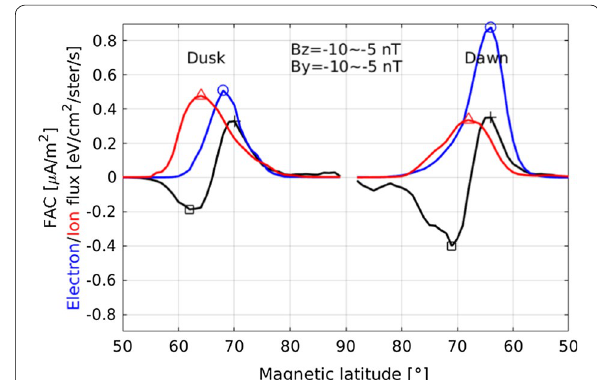
Fig. 8 The latitudinal profiles of FACs (black), electron (blue), and ion (red) in the northern hemisphere with B z and B y both within 10– 5 nT. For both dusk and dawn sides, the upward and − − downward peaks of FACs are marked with black cross and rectangle, while the peaks of electron and ions energy fluxes are marked with blue circle and red triangle, respectively